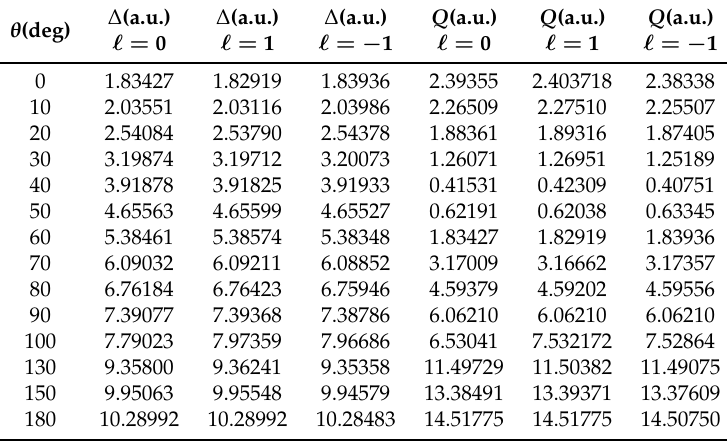
Table 1. The magnitude of the momentum transfer ∆ , and of the recoil momentum of the ion Q , as a function of the scattering angle θ , for a fully symmetric coplanar geometry, in the case of the laser-assisted (e, 2e) reaction, at an incident electron energy of 250